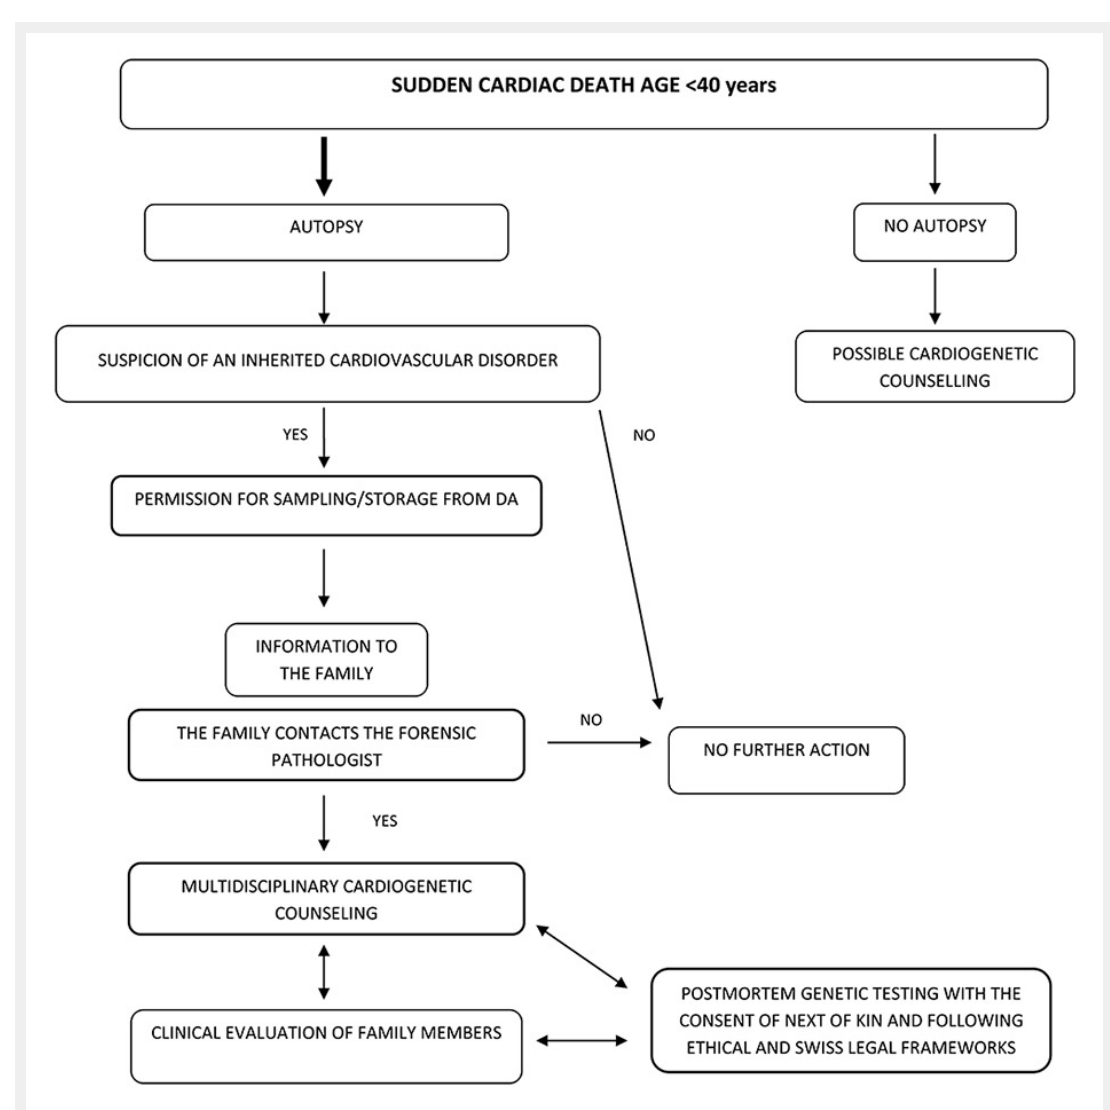
Figure 1 Flowchart of the recommended actions after a sudden cardiac death (SCD) and forensic autopsy. Even if an autopsy is not performed, cardiogenetic counselling is advised after a presumed SCD. More explanations in” Recommended course of action in Swiss practice for